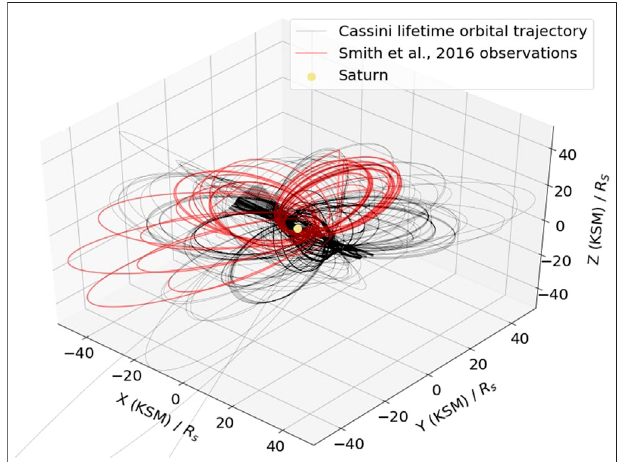
FIGURE 2 | Lifetime trajectory (black) of Cassini around Saturn (yellow). TheCassinitrajectoriesduringtheobservingwindowemployedinthecreation of the Smith et al. (2016) catalog of magnetic reconnection are highlighted in red for comparison. For the creation of a machine learning training set, observations of events are taken from the Smith catalog and null events are randomly taken from a variety of local times and radial distances during the Smith catalog observing